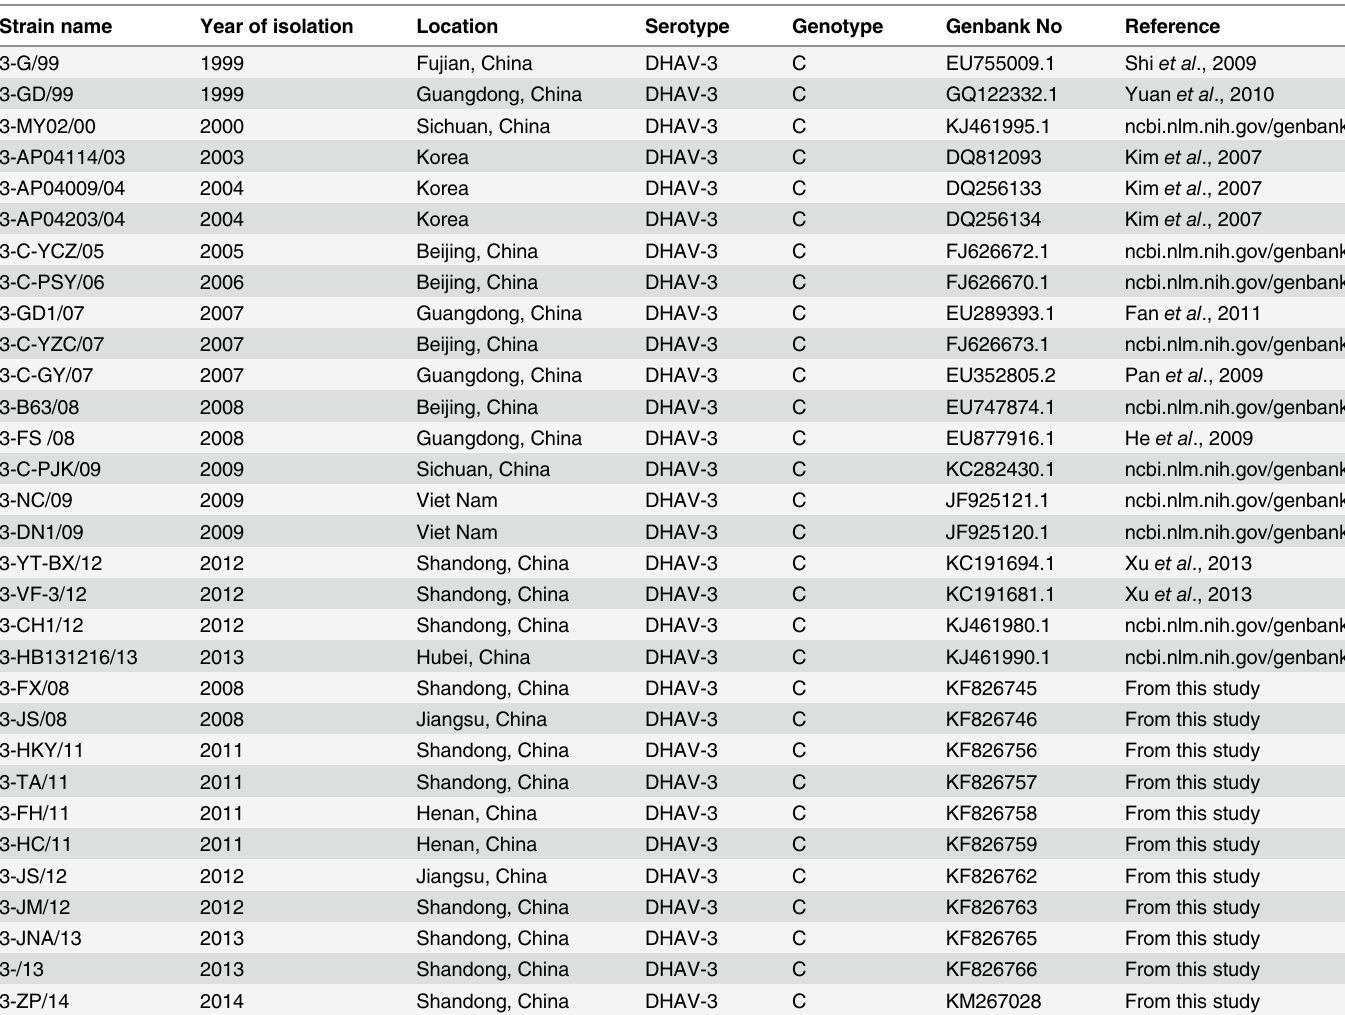
Table 2. Summary of DHAV-3 strains used in this